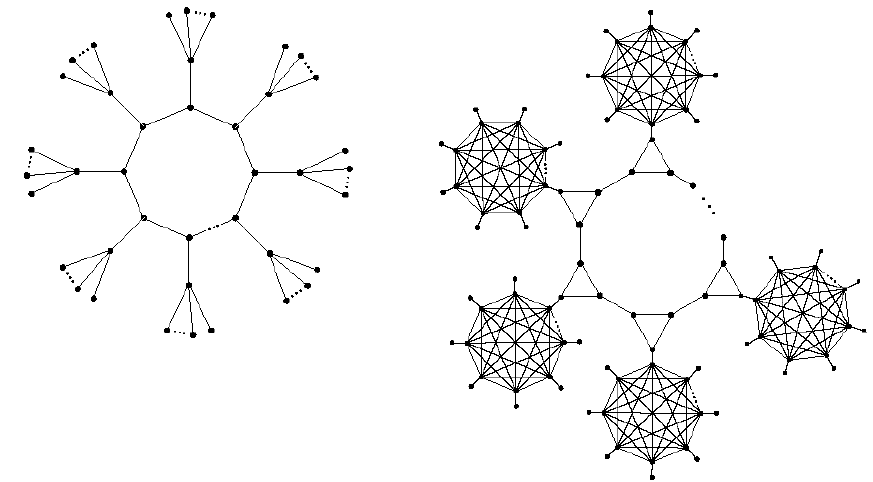
Figure 2. The graph of C n { S m + 1 } ; Line graph of the subdivision graph of C n { S m + 1 } .